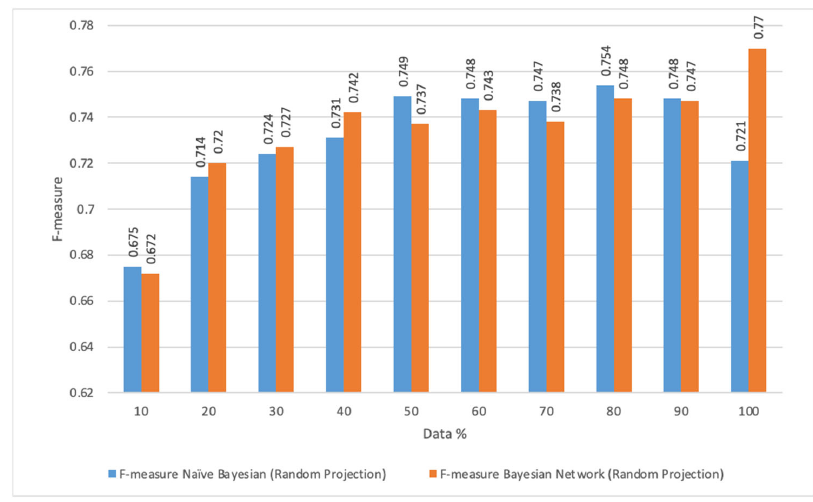
Figure 9. Comparative F-measures for Naïve Bayesian and Bayesian Networks with a random projection.